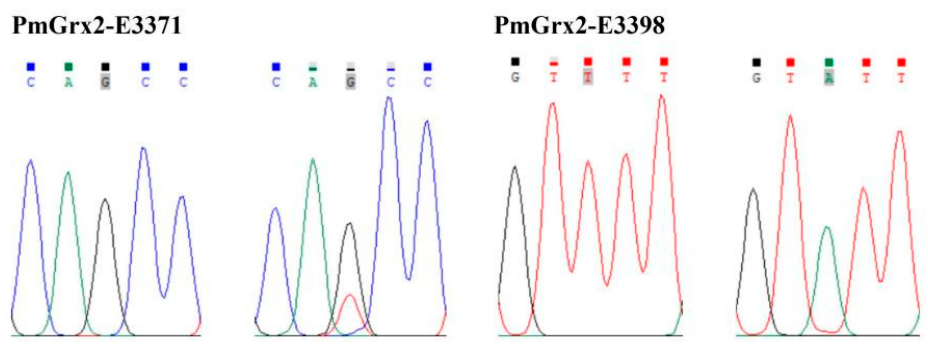
Figure 6. Expression profiles of five genes ( PmTrx ( A ), PmPrx1 ( B ), PmCAT ( C ), PmCYC ( D ), and